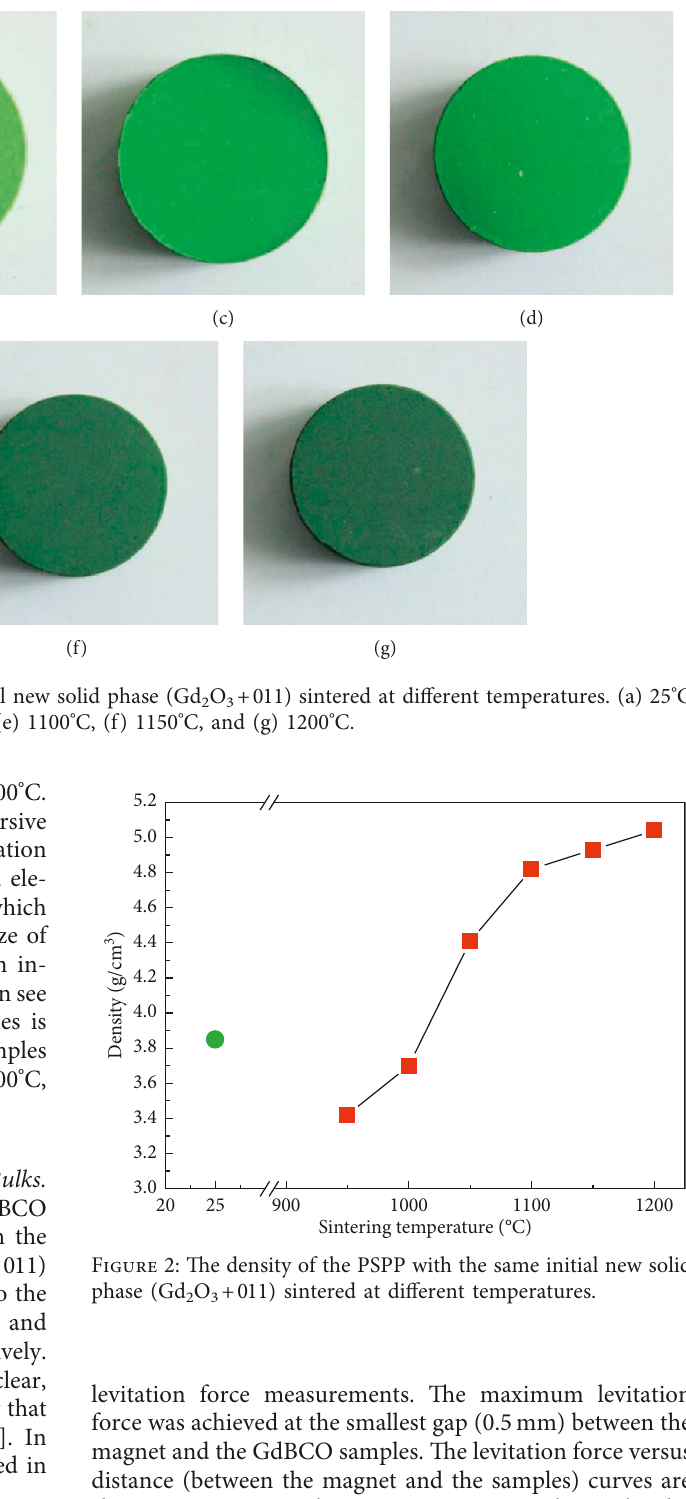
Figure 2: The density of the PSPP with the same initial new solid phase (Gd 2 O 3 +011) sintered at different